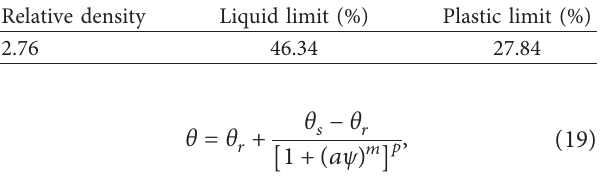
Table 1: Basic physical parameters of Hunan clay. Relative